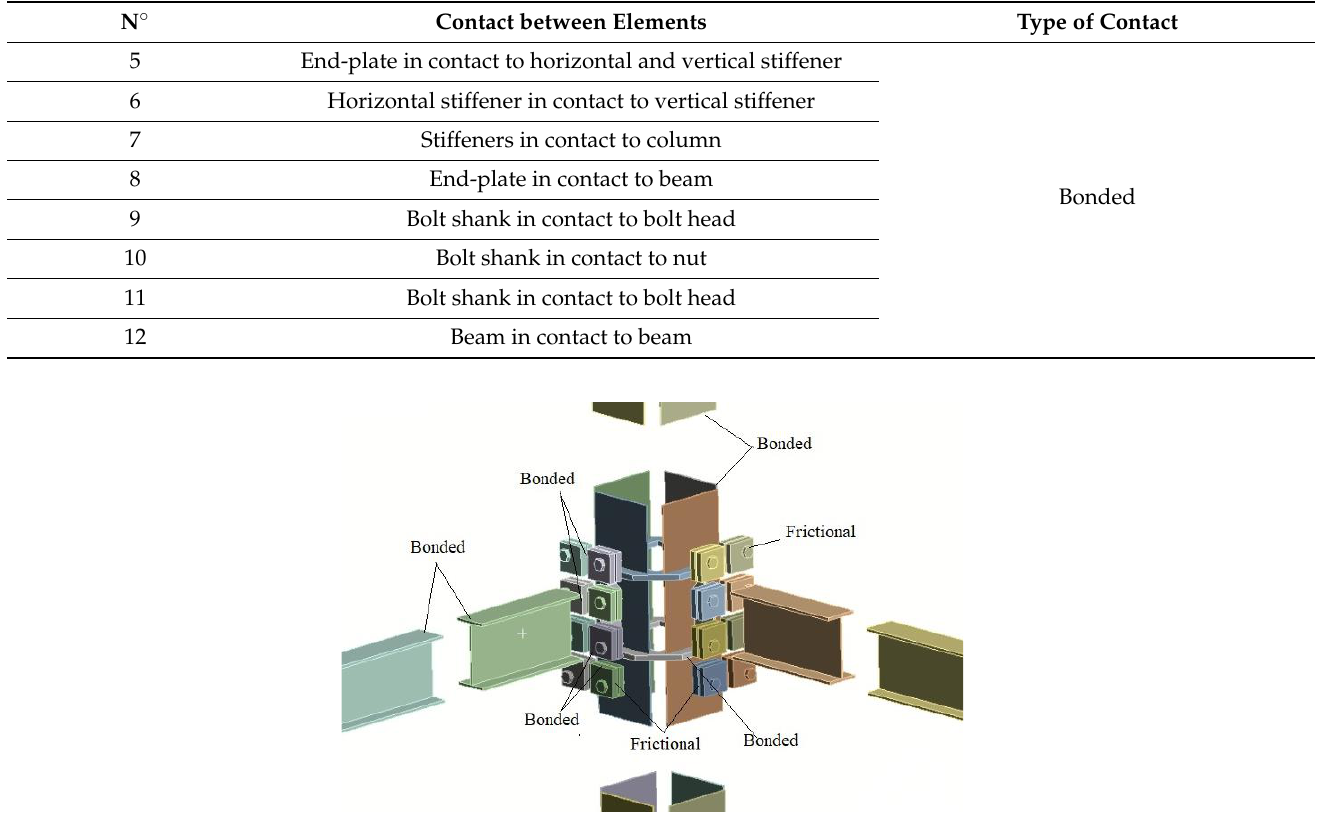
Figure 8. Schematic view of the contacts employed.